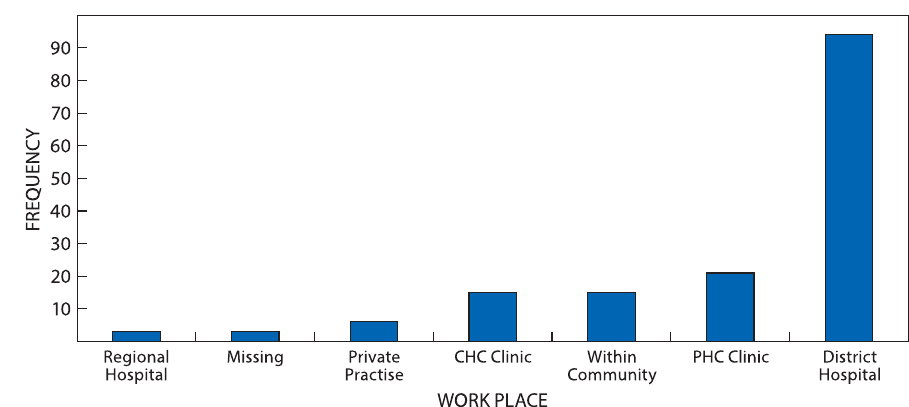
Figure 1: Students ’ perceptions of the main workplace for family physicians. PHC: Primary Health Care, CHC: Community Health Centre.